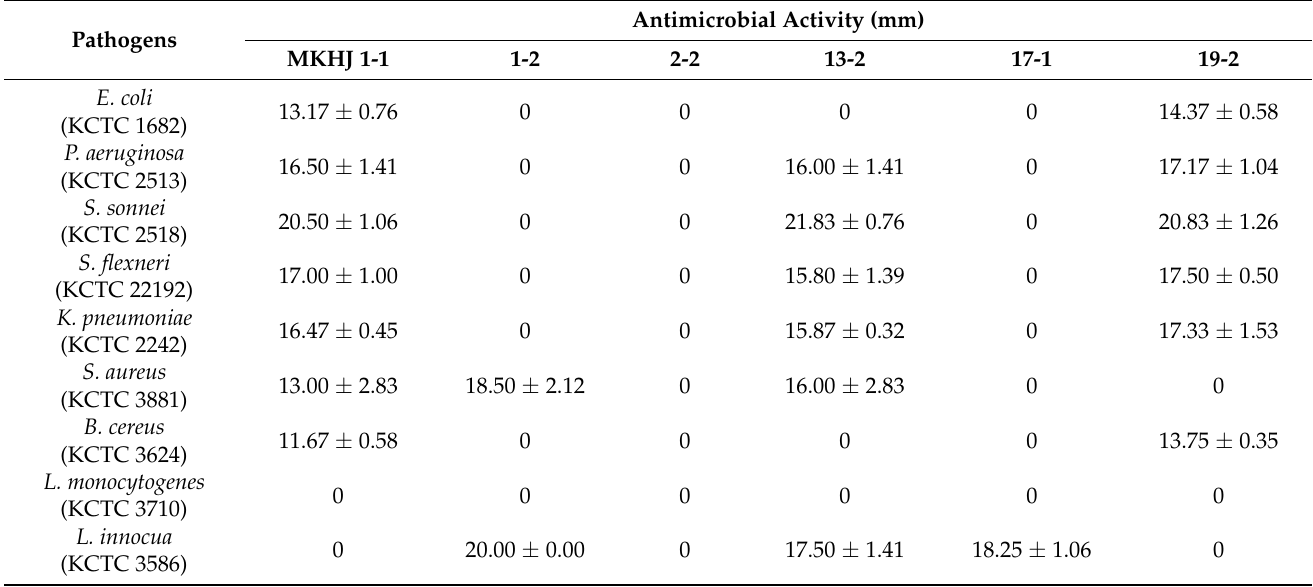
Table 3. Antimicrobial activity of Bacillus strains against pathogenic bacteria.